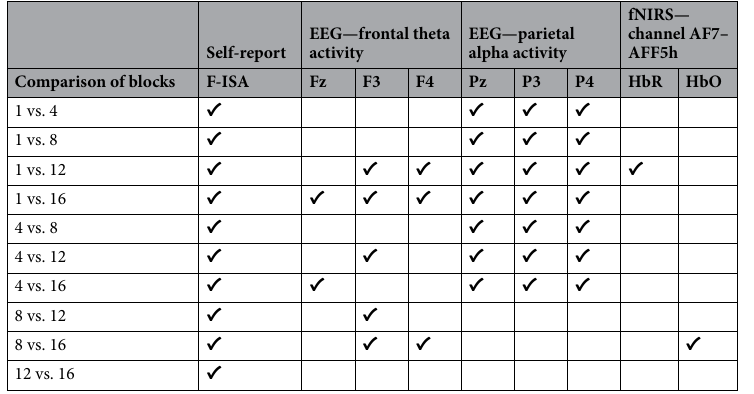
t (30) = − 7.66, p < 0.001. Mean F-ISA ratings increased by 1.42 points between block 1 and 16, from 1.61 (“low”) to 3.03 (“medium/relaxed wakeful”), see Fig. 1a). The ANOVA showed a significant effect of ToT on F-ISA,